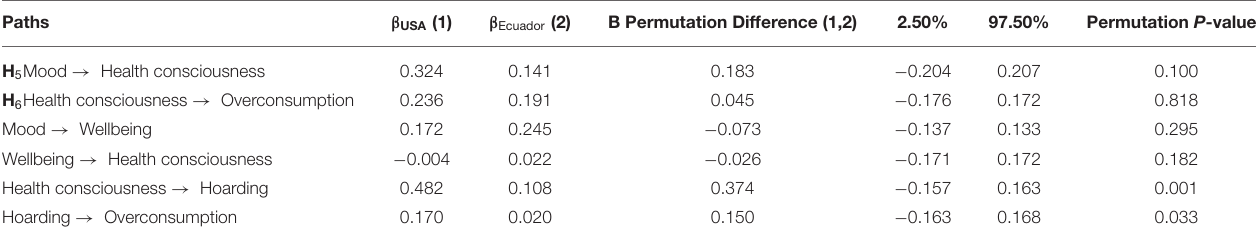
TABLE 6 | Multigroup analysis.